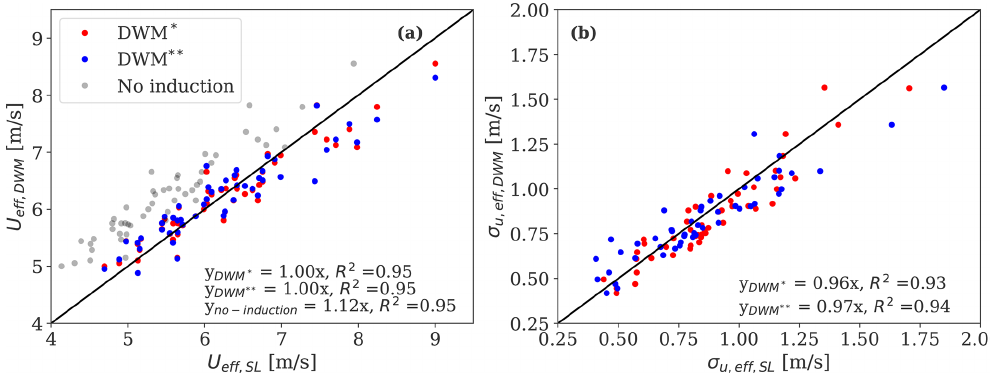
Figure 14. Comparison of the SpinnerLidar-measured (SL) and DWM-model-predicted rotor-effective wind speeds U eff (a) and rotor- effective turbulence σ u, eff (b) . The DWM ∗ predictions (red markers) are obtained by constraining the meandering on the basis of SpinnerLidar-tracked wake displacements, while DWM ∗∗ uses mast-based meandering time series (blue markers). The SpinnerLidar U eff statistics derived by neglecting induction effects are shown by grey markers (see Sect. 6.1 for more details).